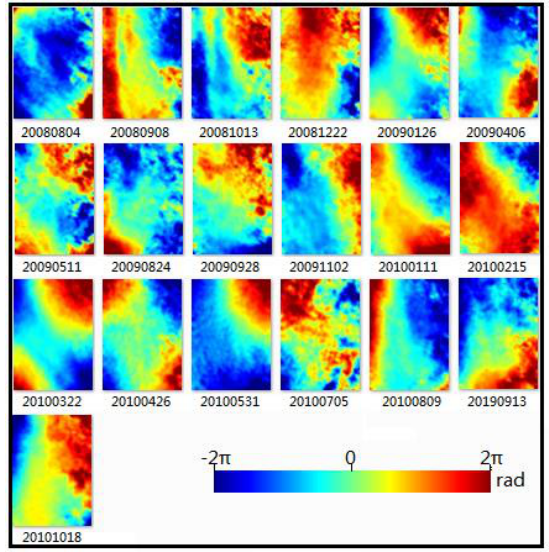
Figure 5. Time series atmospheric delay phase